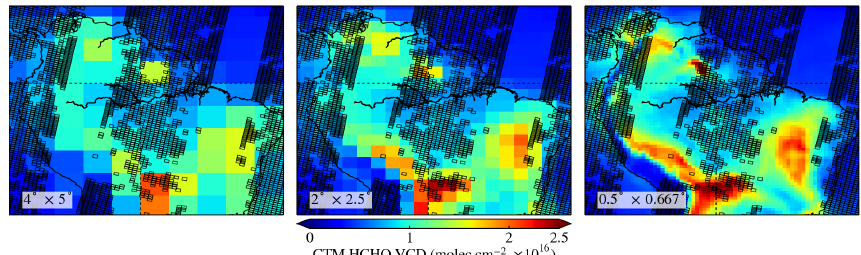
Figure 2. Model HCHO vertical columns over the Amazon simulated by GEOS-Chem at three different spatial resolutions (left to right: 4 ◦ × 5 ◦ , 2 ◦ × 2.5 ◦ , 0.5 ◦ × 0.667 ◦ ). Overlain in black are three typical orbital tracks showing the footprint of each GOME-2 observation with cloud fraction < 40%.